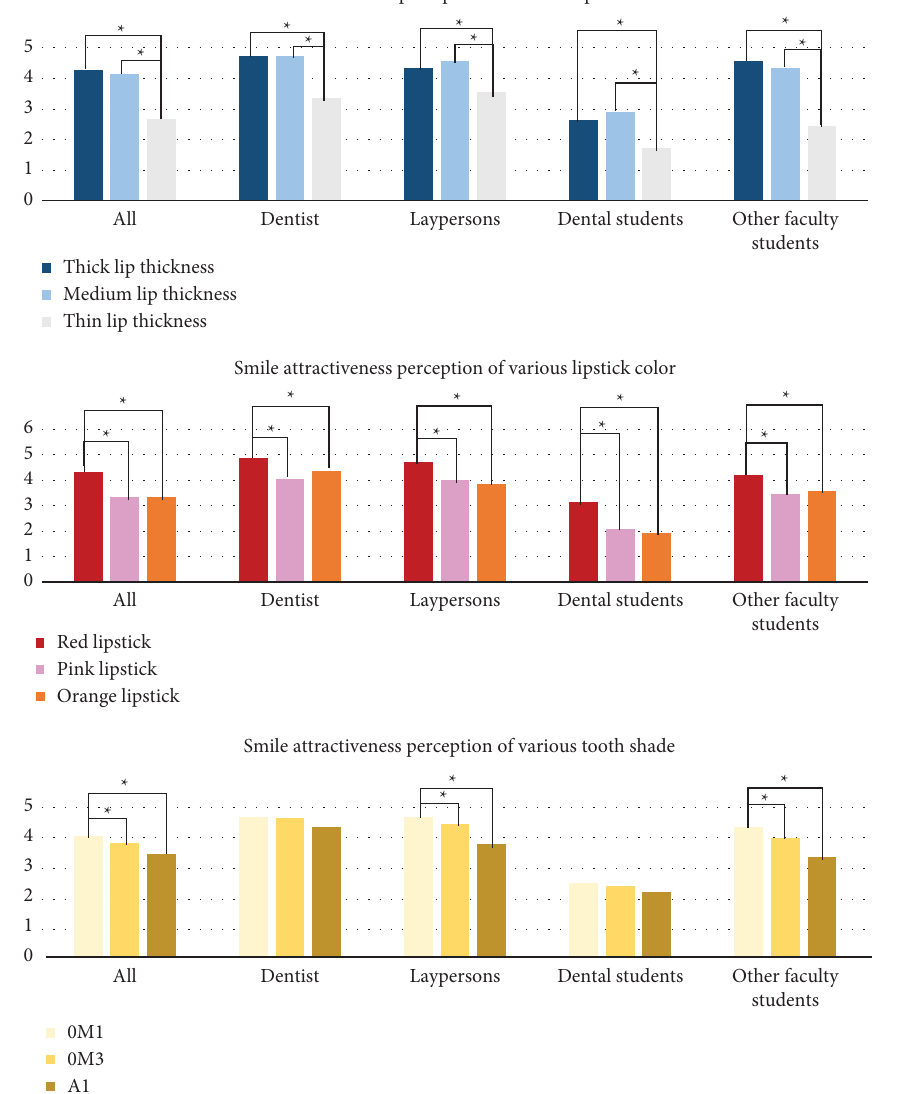
Figure 4: Bar chart of median visual analog scale scores for smile attractiveness perception as evaluated by each variable by all participants and each rater group. Te asterisk bracket ( ∗ ) indicates signifcant diferences between groups ( P ≤ 0 .